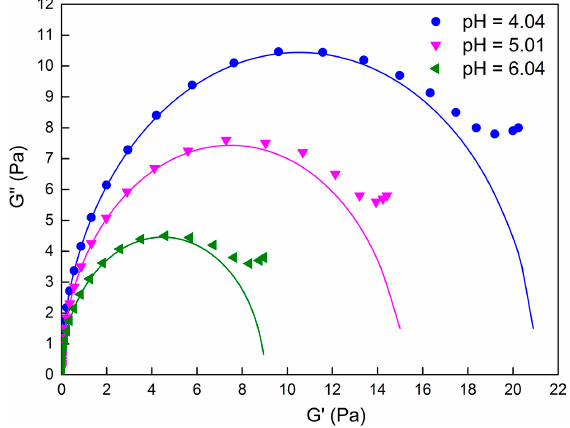
Figure 4. The variation of G” as a function of G ’ of 80 mM C 16 MPBr-AA aqueous solution with different pH values.